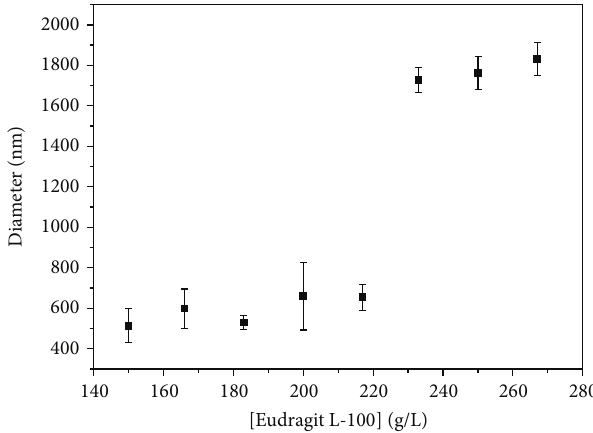
Figure 3: Dependence of diameter of electrospun fibers versus concentration of Eudragit